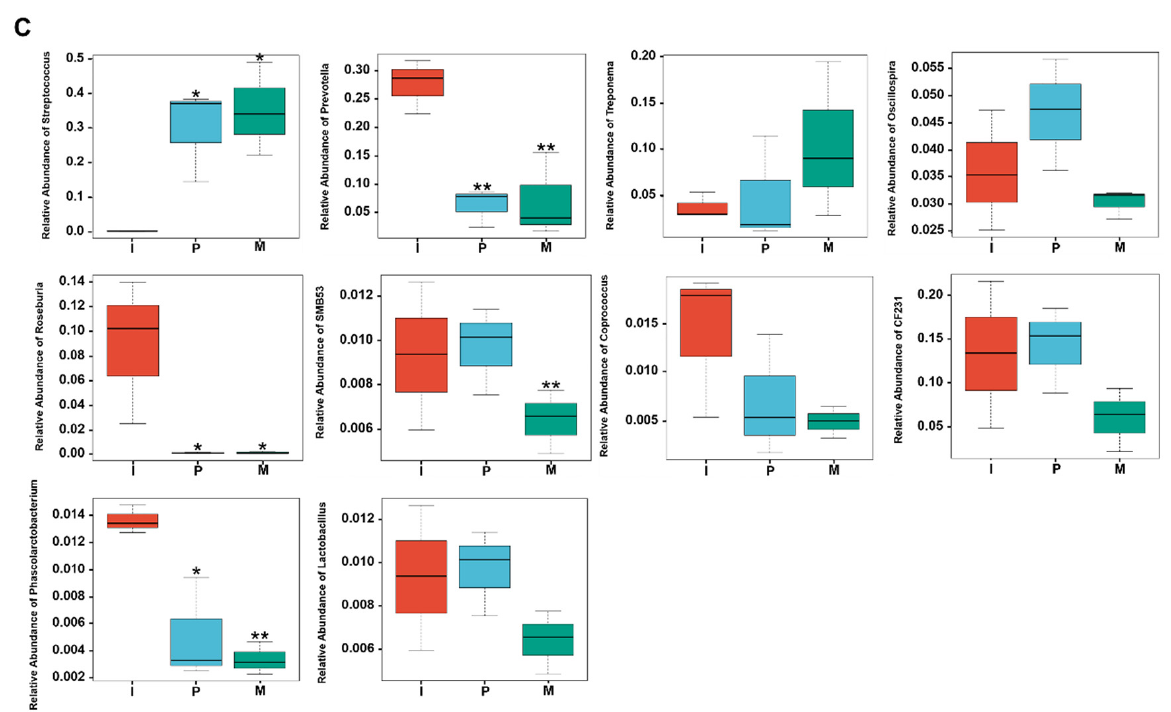
Figure 6. Comparative analysis of gut microbial community structure in different piglet groups. ( A ) Comparison box chart of microbial community structure at the Phylum level; red represents group I, blue represents group P, green represents group M; ( B ) Heat map of the 50 most abundant genera of each group; the red block indicates that the Genus was more abundant in that sample than in other samples, and the blue block indicates that the Genus was less abundant in that sample than in other samples; ( C ) Comparison box chart of microbial community structure at the Genus level. Different asterisks indicate significant differences * ( p < 0.05), ** ( p < 0.01).